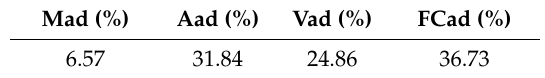
Table 1. Proximate analysis of low-rank coal (LRC) sample